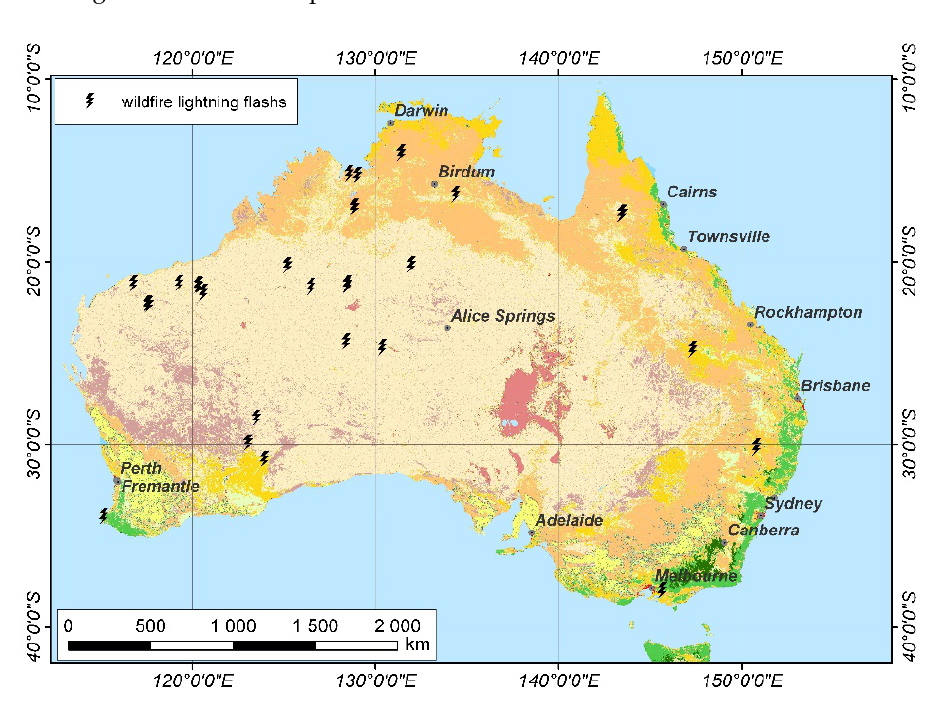
Figure 9. The MODIS land cover map (MCD12Q1, 2018) is used as a background image. The monthly distributions of lightning wildfires that occurred over the specified IGBP land cover vegetation classes are presented in Table 4.